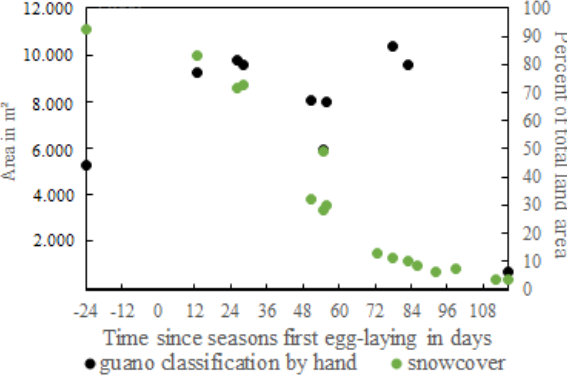
Figure 8. Season 2016/17: connection between snow cover and